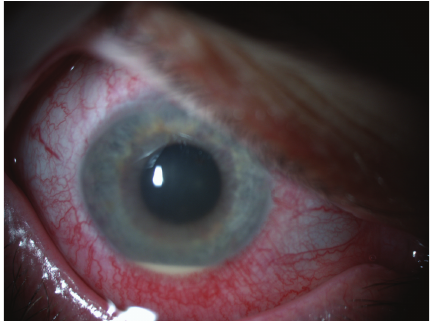
Figure 1: Initial presentation—anterior segment.